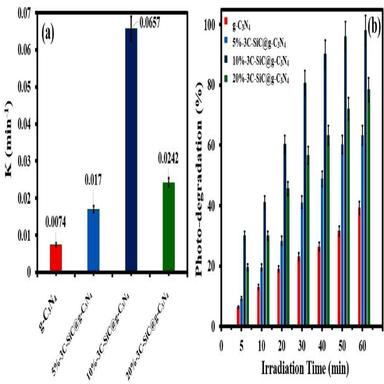
Photocatalytic degradation rate constants with g-C3N4, 5%-3C–SiC@g-C3N4, 10%-3C–SiC@g-C3N4 and 20%-3C–SiC@g-C3N4 under visible light radiation (a) and percentage of photocatalytic degradation of MB dye using g-C3N4, 5%-3C–SiC@g-C3N4, 10%-3C–SiC@g-C3N4 and 20%-3C–SiC@g-C3N4 under visible light radiation at different time intervals.